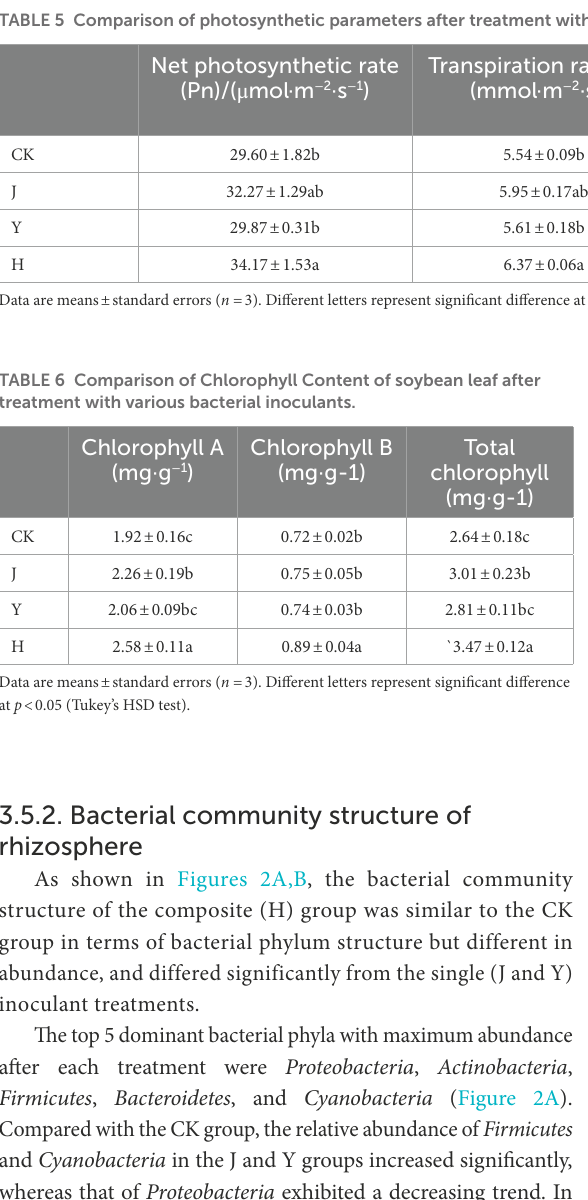
TABLE 5 Comparison of photosynthetic parameters after treatment with various bacterial inoculants.